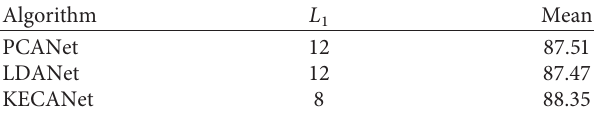
Table 3: The recognition rate of JAFFE database. Algorithm